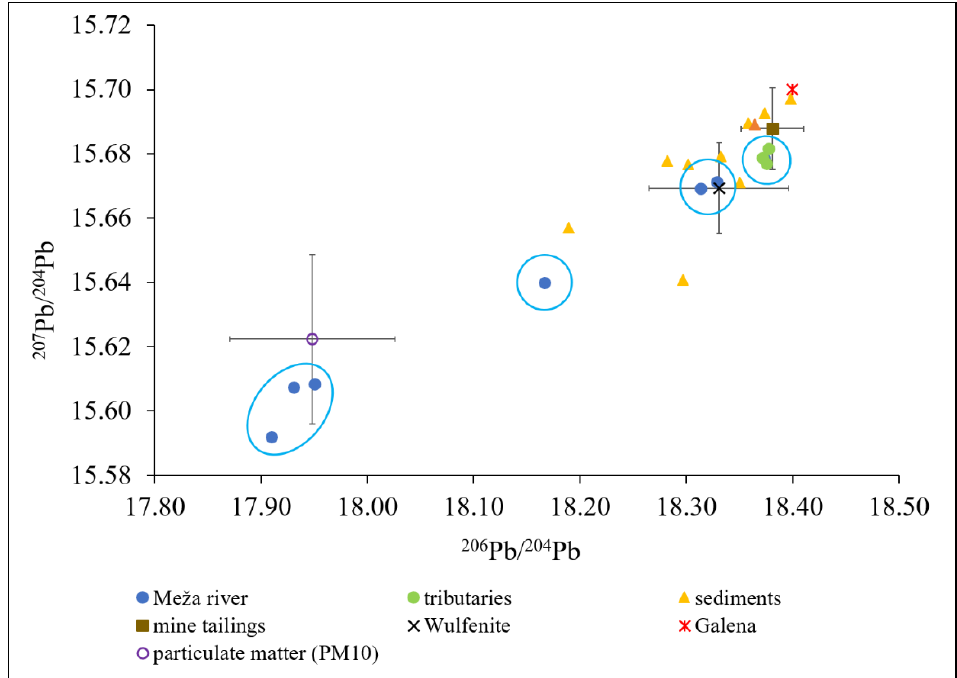
Figure 3. Pb isotope compositions of water and sediment samples from the Meža River and its trib- utaries on a biplot of 207 Pb/ 204 Pb with 206 Pb/ 204 Pb. The orange triangle marker for sediments repre- sents the sample from Črna 2 with fraction <0.250 mm. Values for mine tailings, particulate matter PM 10 and wulfenite are from our unpublished data, and the value for galena is from Miler and Gosar [39].